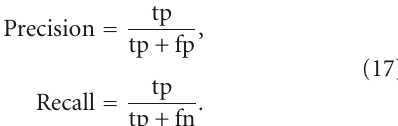
Figure 10: Maximum activity descriptor B for MW01 trained on a vertical line (parallel to the y -axis) in the sequence, showing clearly the gaps in the model due to short training sequence. This causes the horizontal streaks of false positive detections by the behaviour subtraction algorithm in Figure